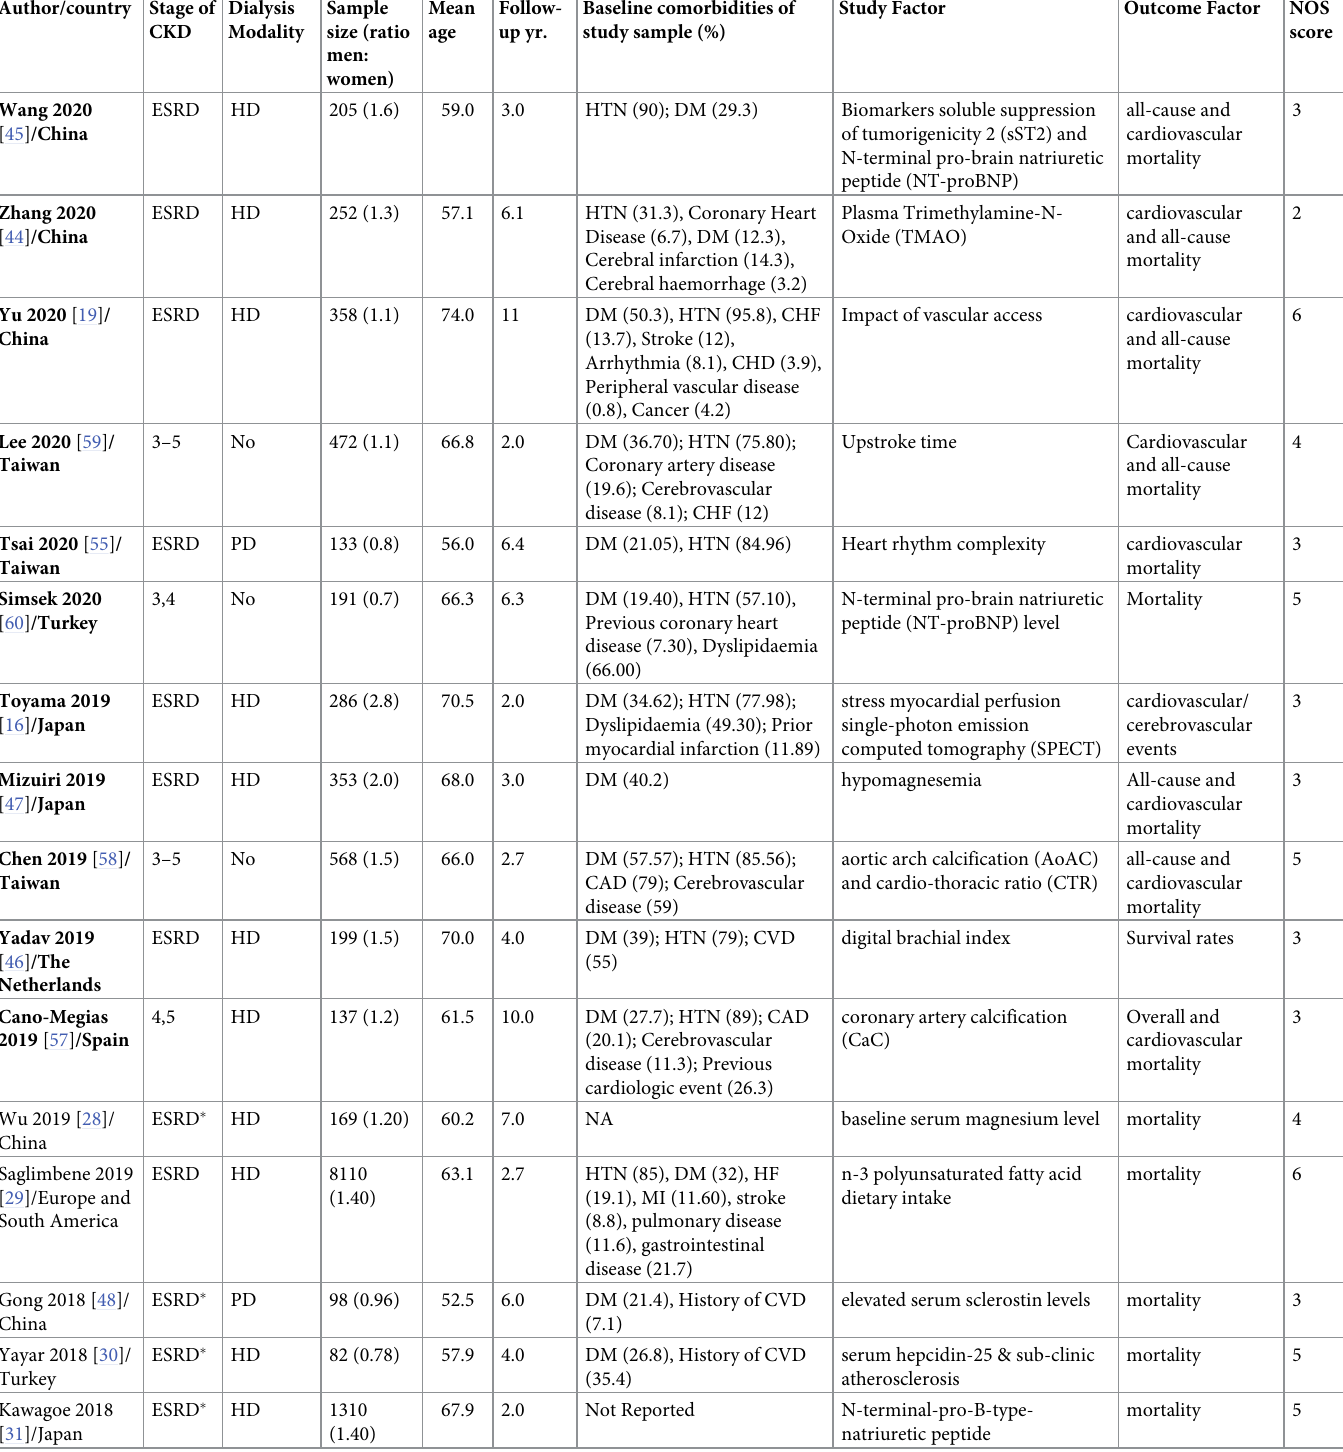
Table 1. Summary of study